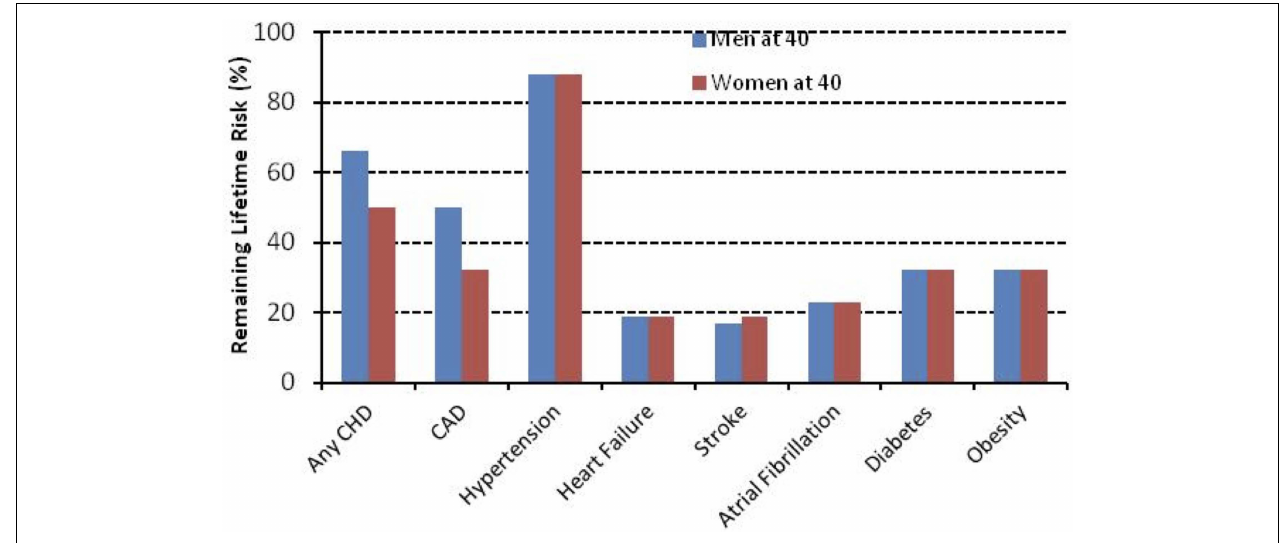
FIGURE 5 | Remaining lifetime risk for cardiovascular disease and other diseases among men and women free of disease at 40years of age from the Framingham Study. Modified from Lloyd-Jones et al.